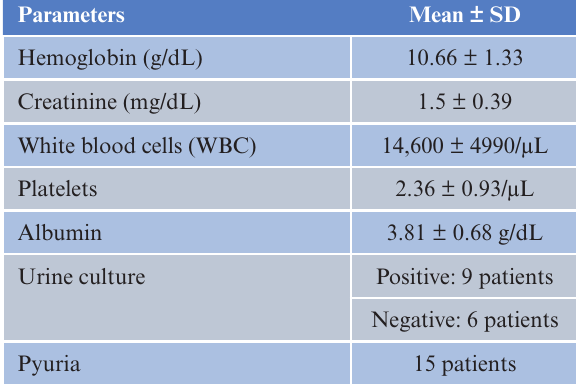
Table 2: Biochemical parameters of